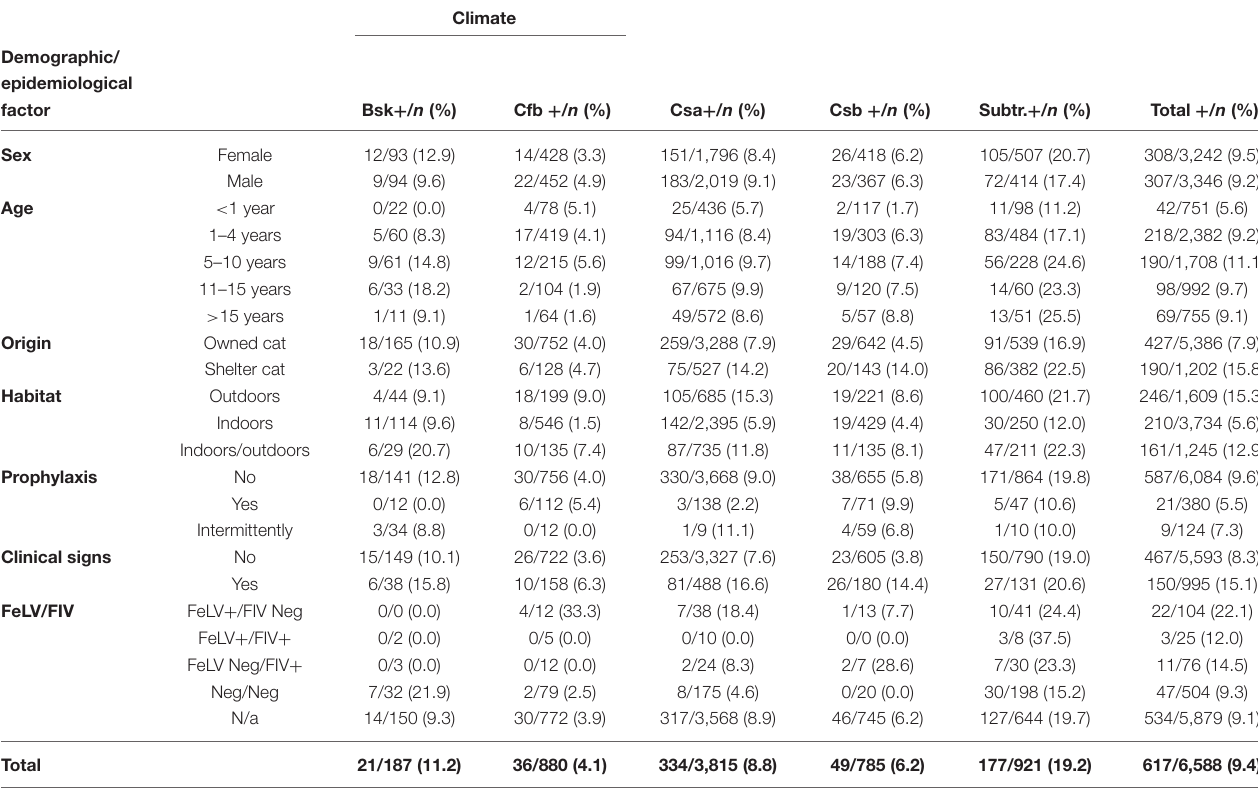
TABLE 2 | Seroprevalences for D. immitis in cats in Spain by climates, (Köppen Climate Classification System), according to sex, age, origin, habitat, use of prophylaxis, presence of clinical signs, and FeLV/FIV status. Climate